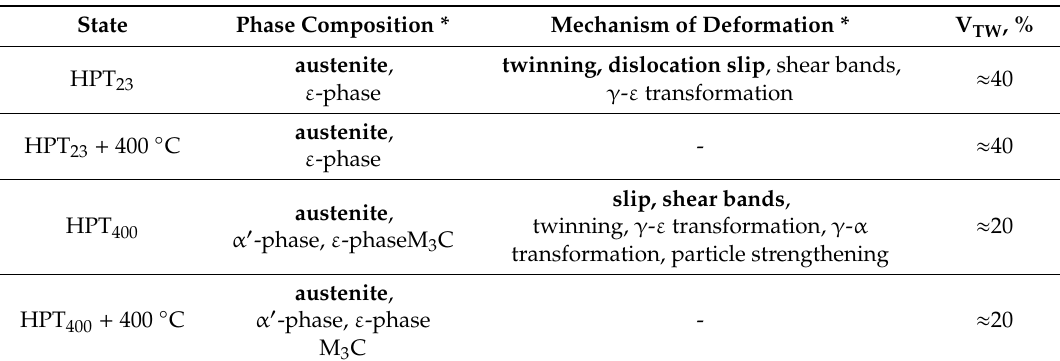
Table 2. Phase composition, deformation mechanisms and twinned volume ( V TW ) of Fe-13Mn-1.3C steel after HPT and post-deformation annealing at 400 ◦